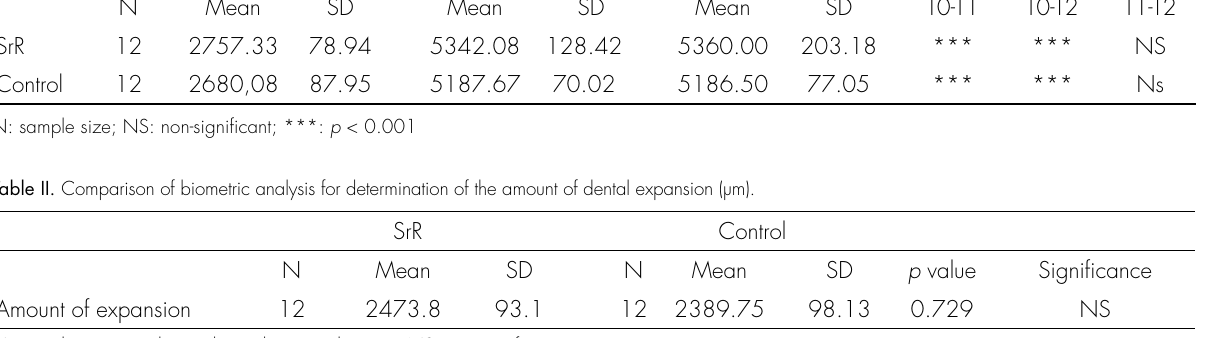
N: sample size; p value: independent samples t- test; NS: